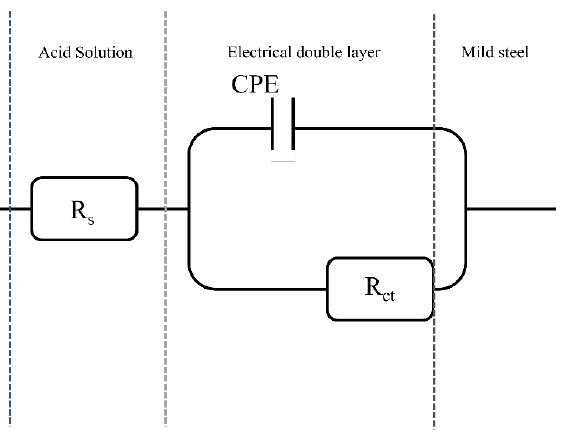
Figure 5. Equivalent electrical circuit of the API X52 steel system in corrosive medium in the pres- ence of [THDA + ][ − AA]. of [THDA + ][ −